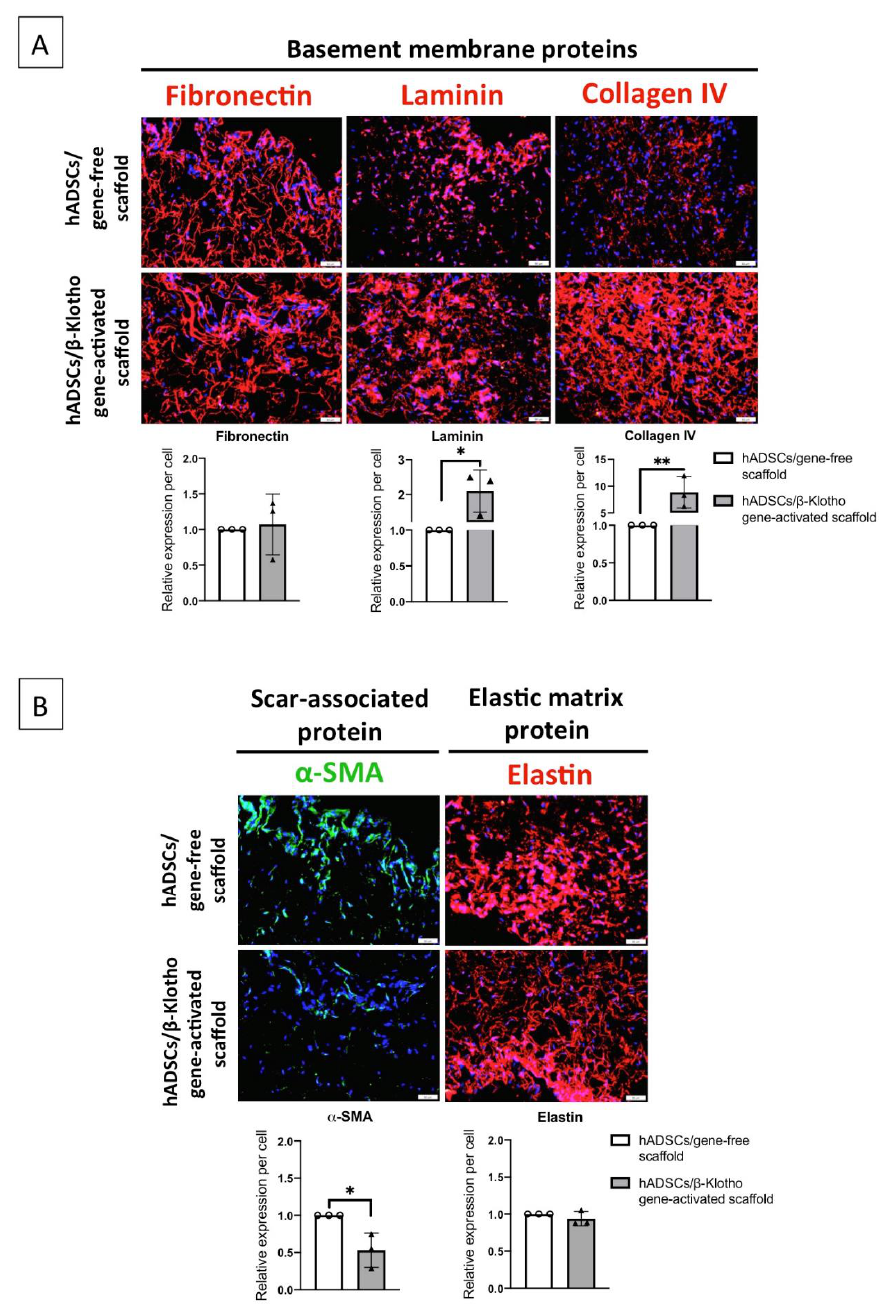
Figure 4. Deposition of pro-wound healing matrix proteins by the ADSCs in the gene-activated scaffold on day 14. ( A ) The ADSCs in the gene-activated scaffold demonstrated significant regeneration of the basement membrane compared to the ADSCs in the gene-free scaffold. The ADSCs predominantly deposited a relatively mature network of collagen IV proteins, followed by laminin and fibronectin. ( B ) The ADSCs in the gene-activated scaffold also expressed 2-fold lower of the α -SMA protein compared to the ADSCs in the gene-free scaffold. In conjunction with basement mem- brane regeneration, the ADSCs in the gene-activated scaffold deposited qualitatively better elastin matrix. All the images were captured through 20 × objective using an IX73 Olympus microscope. ** and * indicates p < 0.01 and p < 0.05 respectively. Scale bar 50 µ m. Data represents mean ± standard deviation ( n = 3). α -SMA and fibronectin was